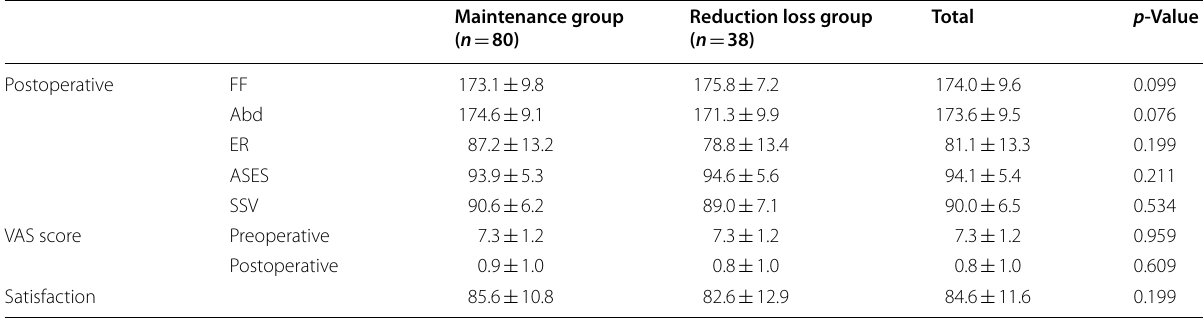
Data are presented as number (percentage) or mean SD ± FF forward flexion, Abd abduction, ER external rotation, ASES American shoulder and elbow surgeons, SSV shoulder subjective value, VAS visual analog scale for